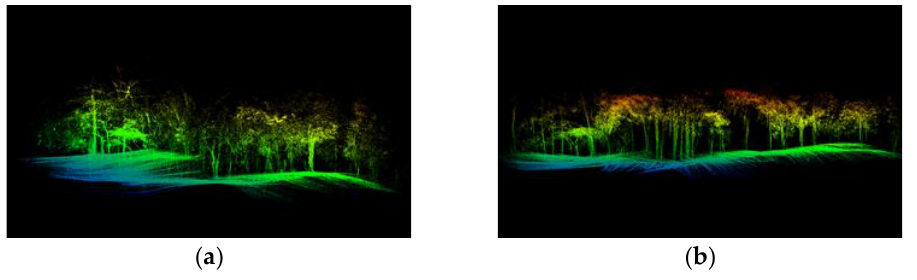
Figure 9. Comparison of reconstruction results of different methods: ( a ) 3D reconstruction based on Kalman filter; ( b ) 3D reconstruction based on the method proposed in this paper. Table 5. Average time cost.